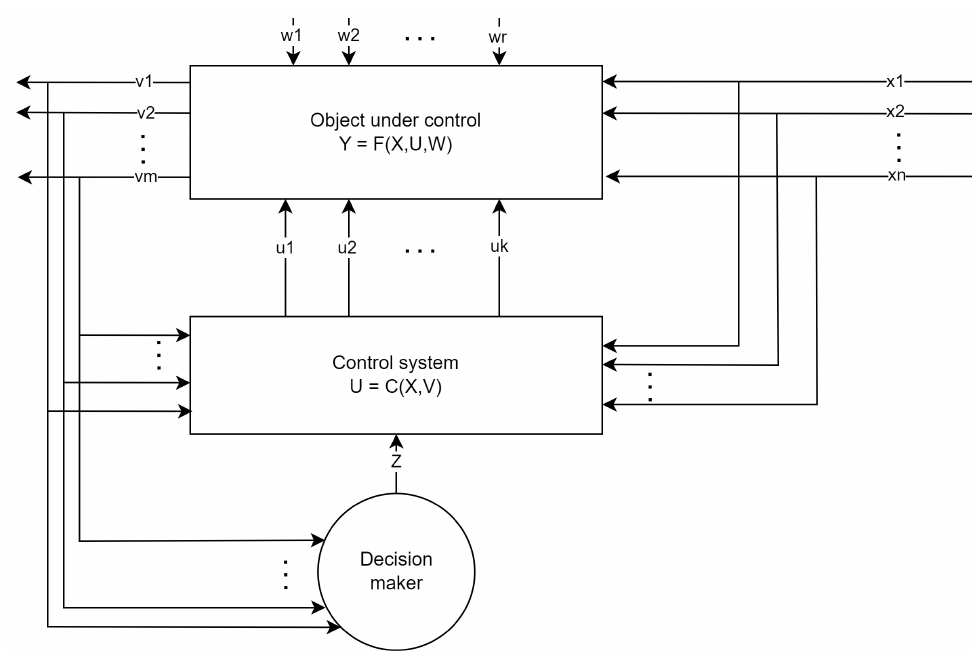
Figure 1. Scheme of the control